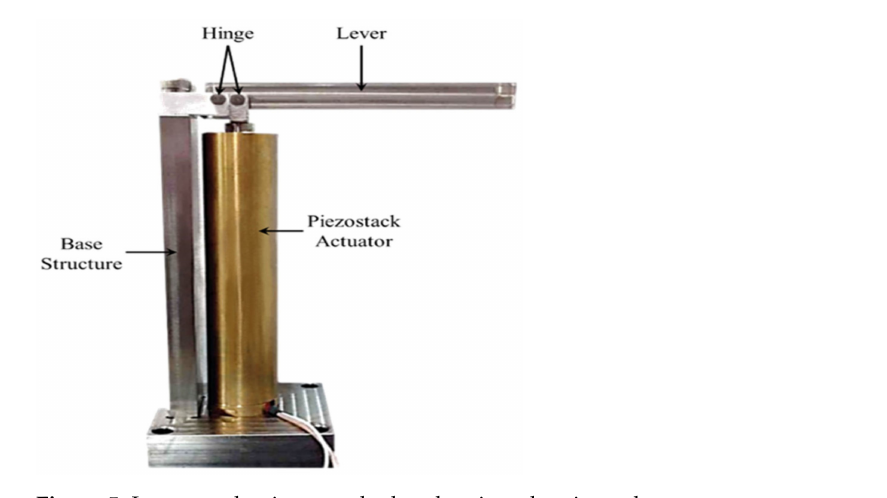
Figure 5. Lever mechanism attached to the piezoelectric stack. Table 2. Design parameters of the lever mechanism.